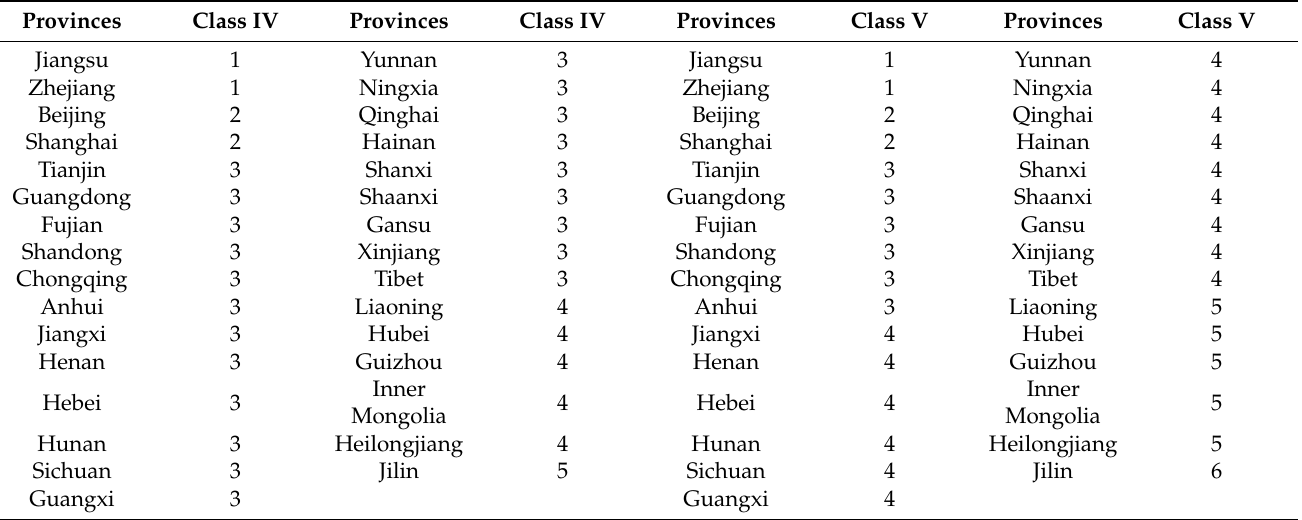
Table 4. Thirty-one PLADs’ land transfer income supports rural revitalization obstacles V and VI clustering